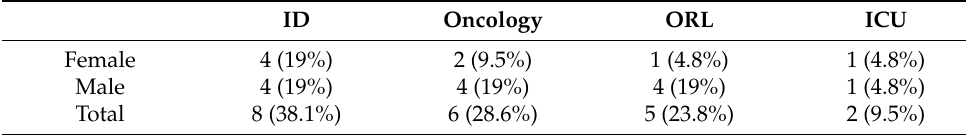
Table 2. Gender and ward distribution of the collected samples.